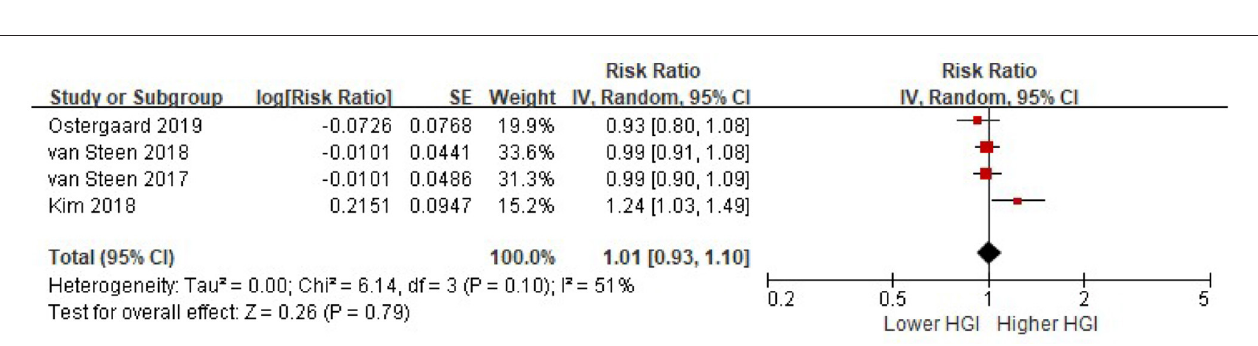
FIGURE 3 | The association between HGI and the risk of all cause mortality. Data were presented as the HR and 95% CI of all cause mortality for per 1 SD increment of HGI, after adjusting for multiple cardiovascular risk factors (without HbA1c). CI, confidence interval; HGI, hemoglobin glycation index.